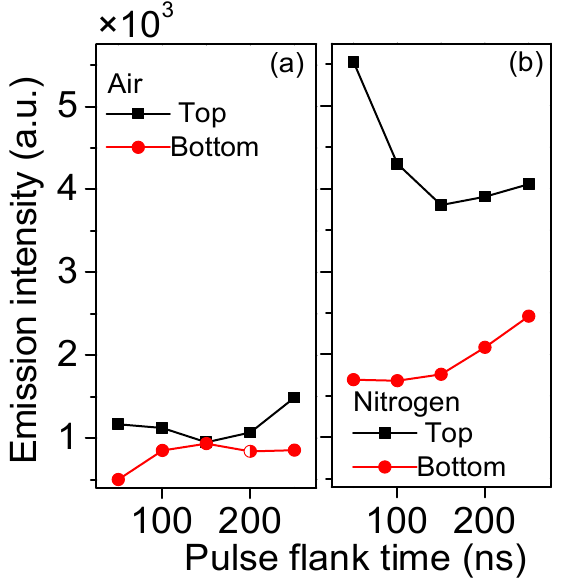
Figure 13. Effects of pulse rising and falling time on the emission intensity of FNS of N 2+ collected from the top and bottom of the reactor in ( a ) air and ( b ) pure nitrogen.